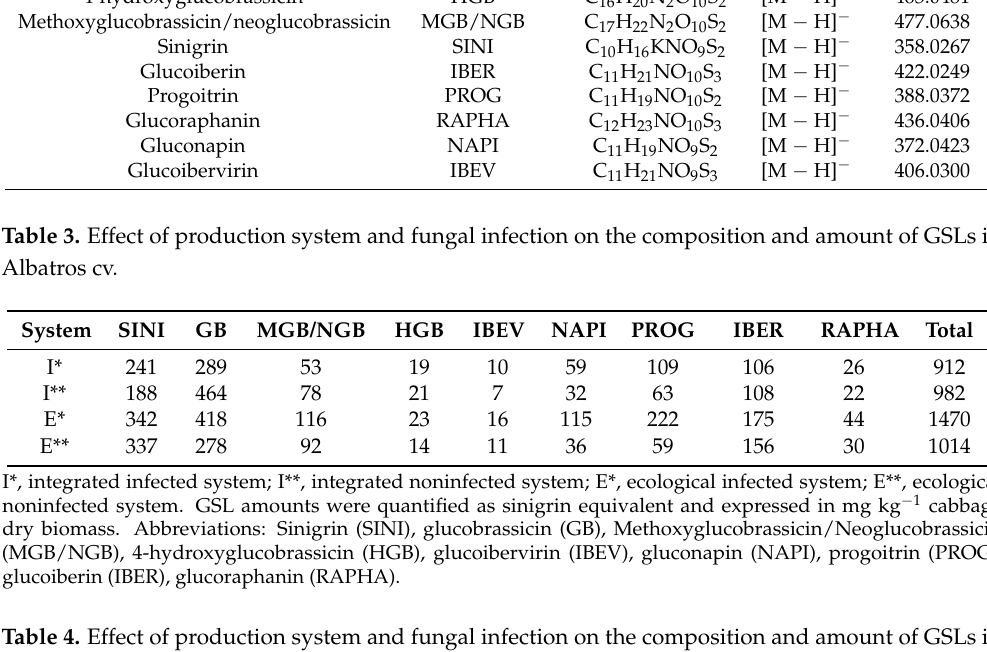
Table 4. Effect of production system and fungal infection on the composition and amount of GSLs in Target